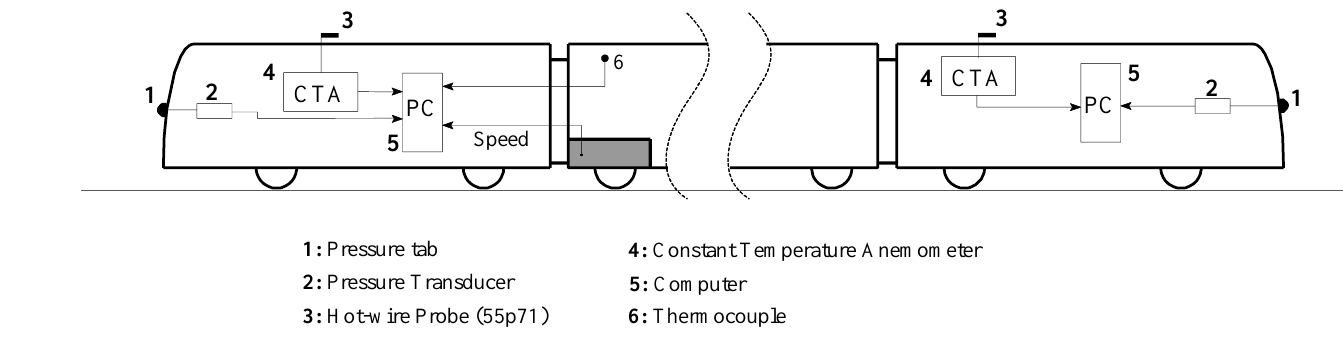
Figure 2. Schematic of the instrumented train.